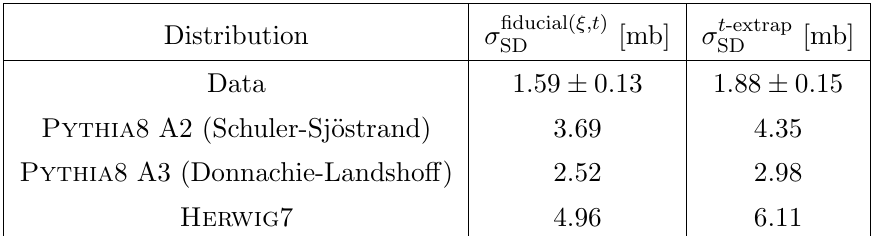
Table 1. The SD cross section within the (cid:12)ducial region ( (cid:0) 4 : 0 < log 0 : 43 GeV 2 ) and extrapolated across all t using the measured slope parameter B . The systematic and statistical uncertainties are combined for data. The MC statistical uncertainties are